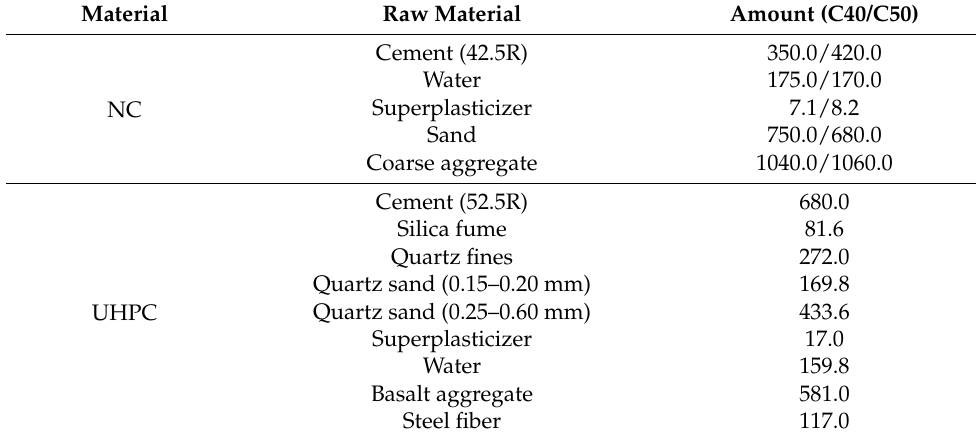
Table 1. UHPC [5] and NC mixtures (kg/m 3 ).